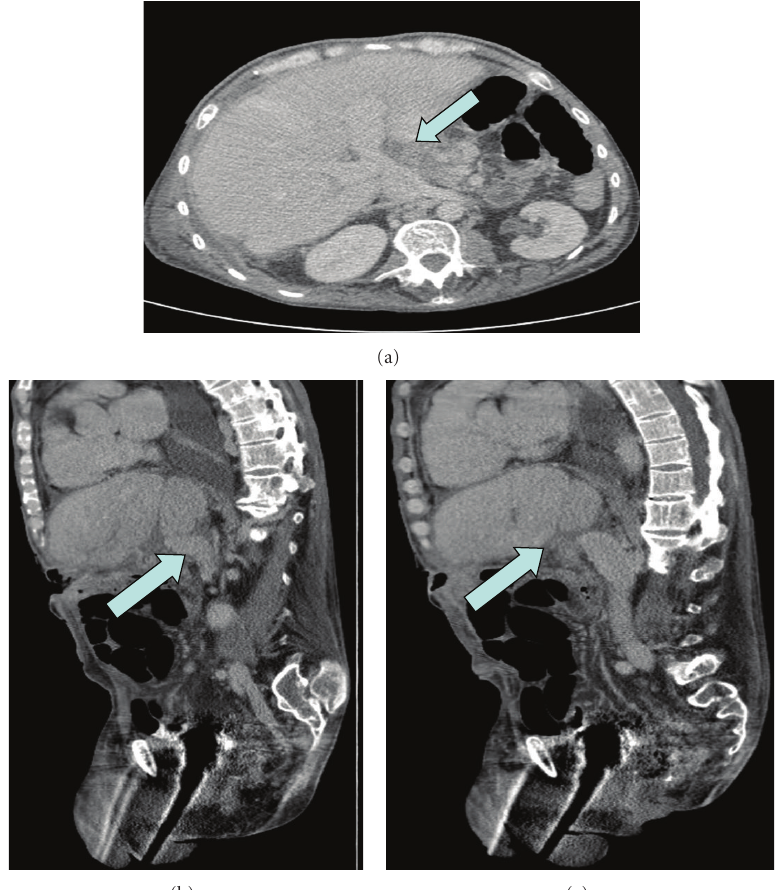
Figure 2: CT venogram showing cavoportal hemitransposition with the donor liver anastomosed to the recipient vena in the piggyback fashion (see